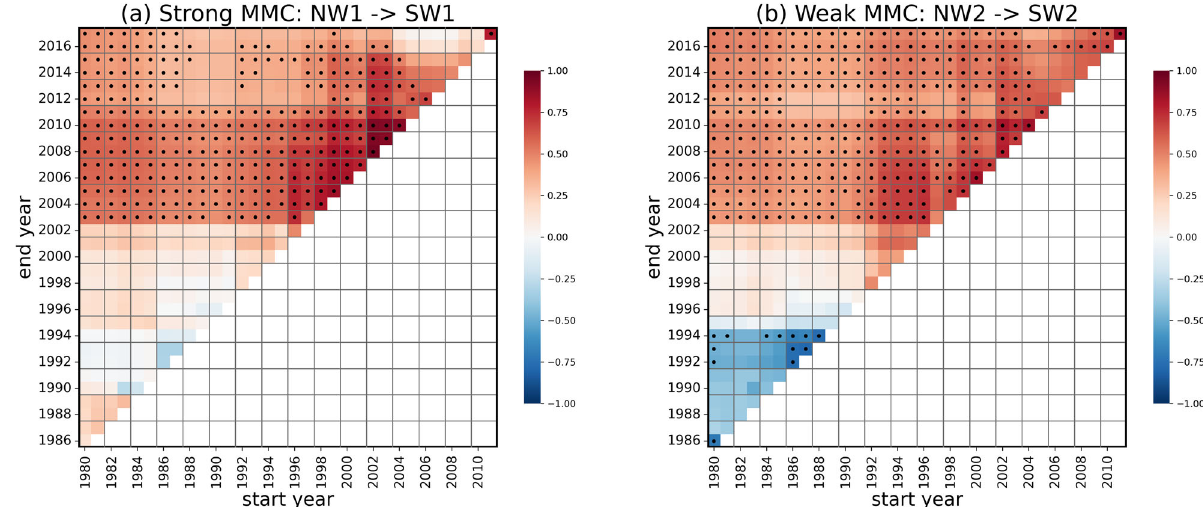
Fig. 8 Lagged correlations between cluster frequency in boreal and austral winters. Time-varying correlations between detrended timeseries of cluster occurrence during a boreal winter and the following austral winter for ( a ) NW 1 and SW 1 , and ( b ) NW 2 and SW 2 . The start of the time interval is indicated by the X -axis and the end year by the Y -axis. Gray dots show values signi fi cant at 90 % level.